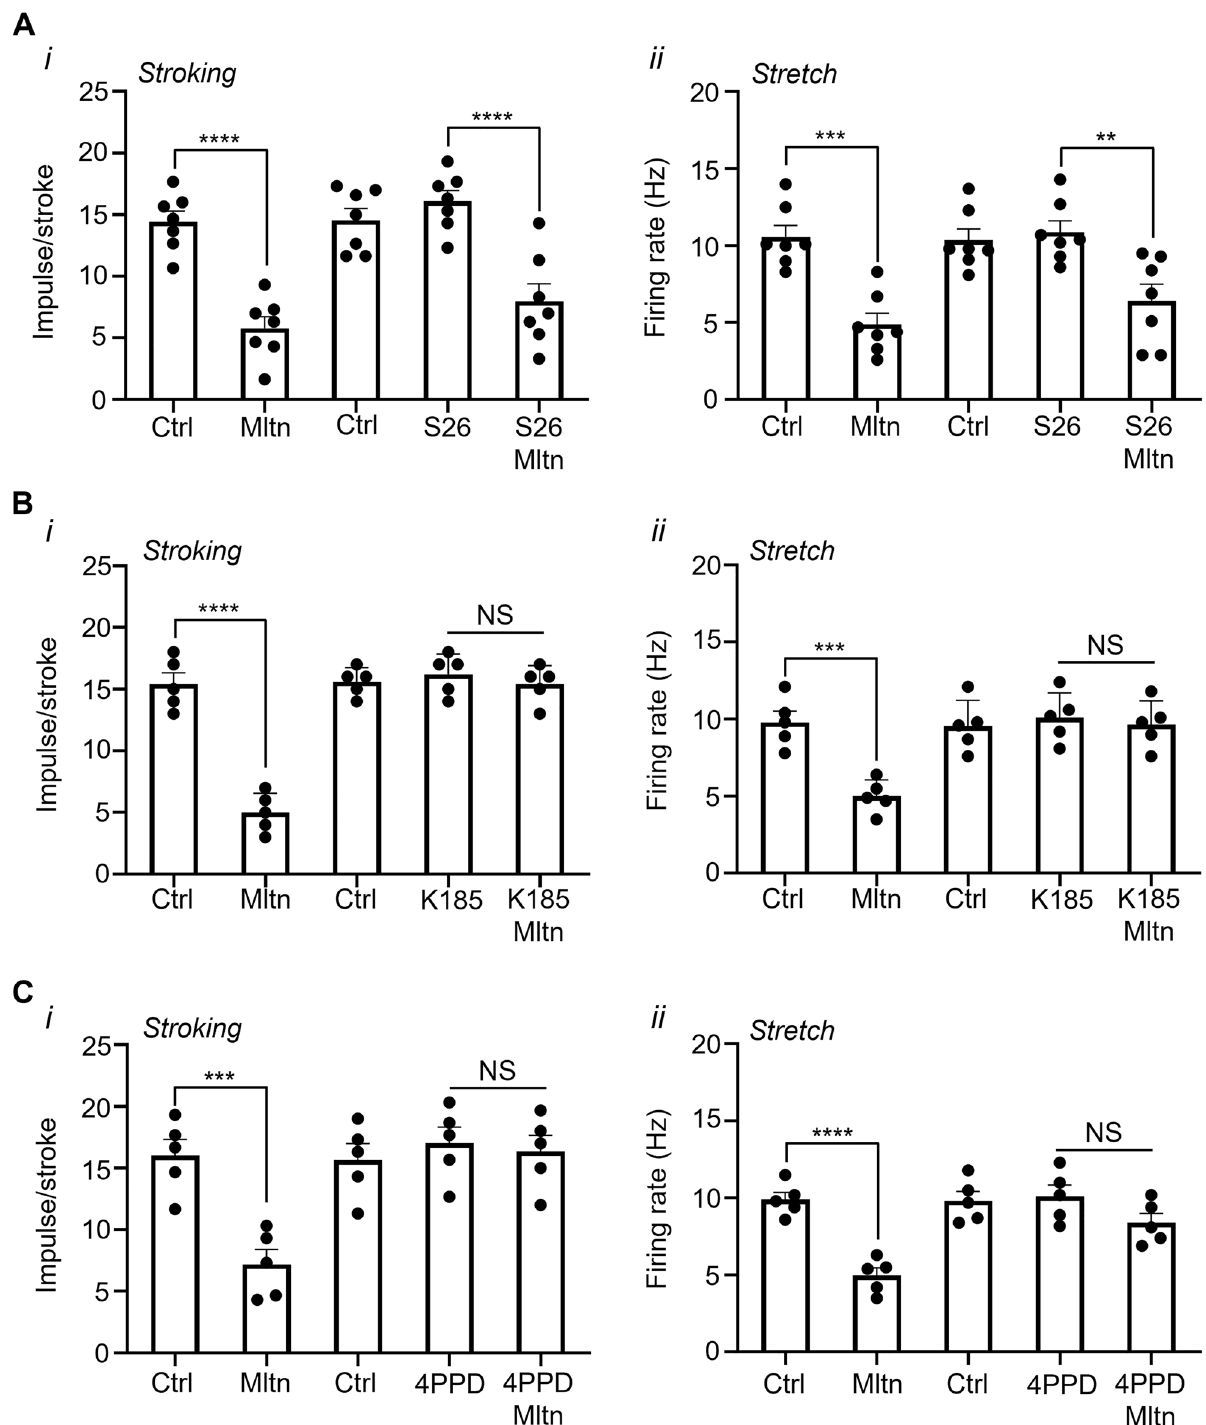
Figure 3. The inhibitory effect of melatonin on muscular-mucosal afferents was abolished by MT2, but not MT1 receptor antagonists. ( A ) The responses of responding bladder muscular-mucosal afferents to ( i ) stroking (100 mg) and ( ii ) stretch (10 g) in the absence and presence of melatonin (Mltn) alone (30 µM) or in combination with the MT1 receptor antagonist, SR26131 (S26; 10 µM). Data is presented as the mean ± the SEM, N = 7, n = 7. **P < 0.01, ***P < 0.001, ****P < 0.0001. ( B ) The effect of melatonin (Mltn; 30 µM) on the responses of muscular-mucosal afferents to ( i ) stroking (100 mg) and ( ii ) stretch (10 g) in the absence and presence of the MT2 receptor antagonist, K-185 (10 µM). ( C ) The effect of melatonin (30 µM) on responses of muscular-mucosal afferents to ( i ) stroking (100 mg) and ( ii ) stretch (10 g) in the absence and presence of the MT2 receptor antagonist, 4-P-PDOT (4PPD; 10 µM). Data is presented as the mean ± the SEM, N = 5, n = 5 per antagonist. ***P < 0.001, ****P < 0.0001 vs